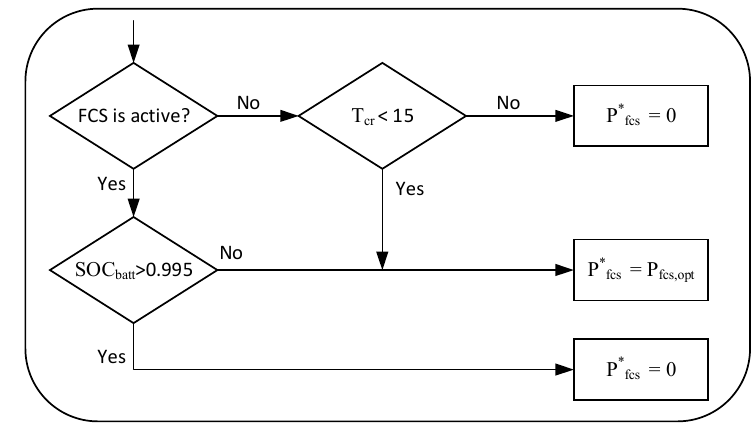
Figure 10. Fixed-Setpoint EMS [28].